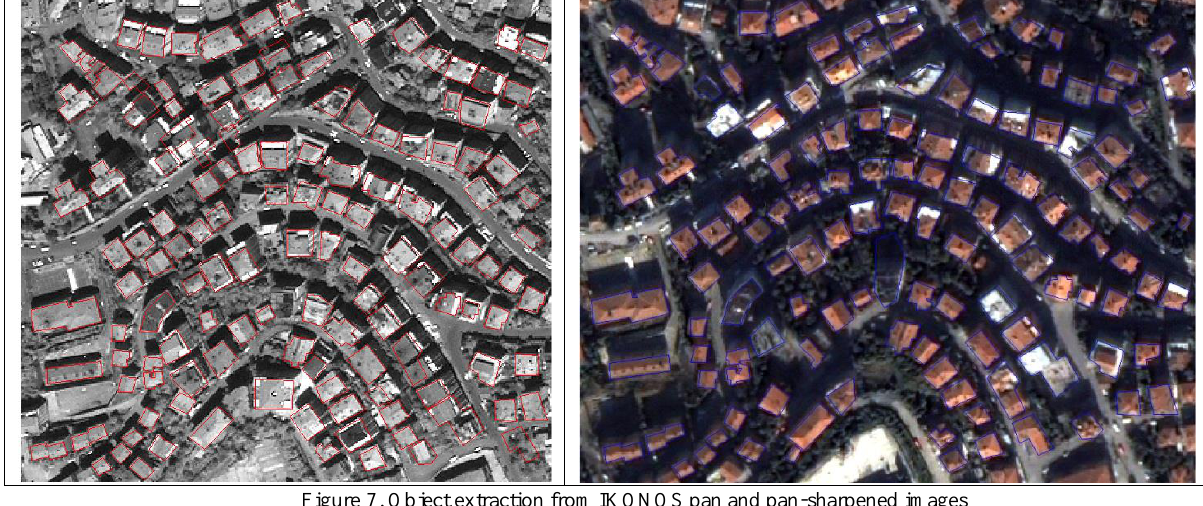
Figure 7. Object extraction from IKONOS pan and pan-sharpened images